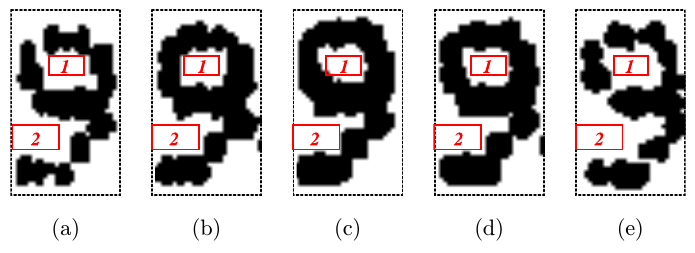
Fig. 12. Several \9" individual images segmented